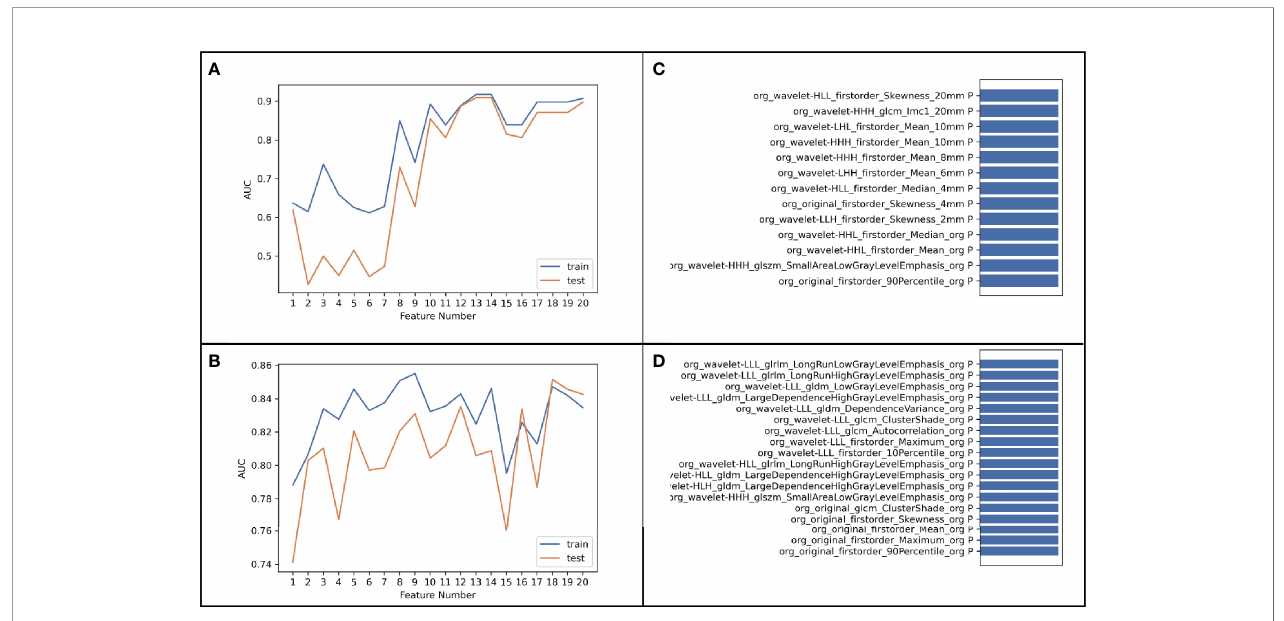
FIGURE 5 | (A, B) was the result of modeling using 6,808-dimensional features extracted in eight-VOI Model, and (C, D) was the result of using 851-dimensional features extracted only in VOI core model.